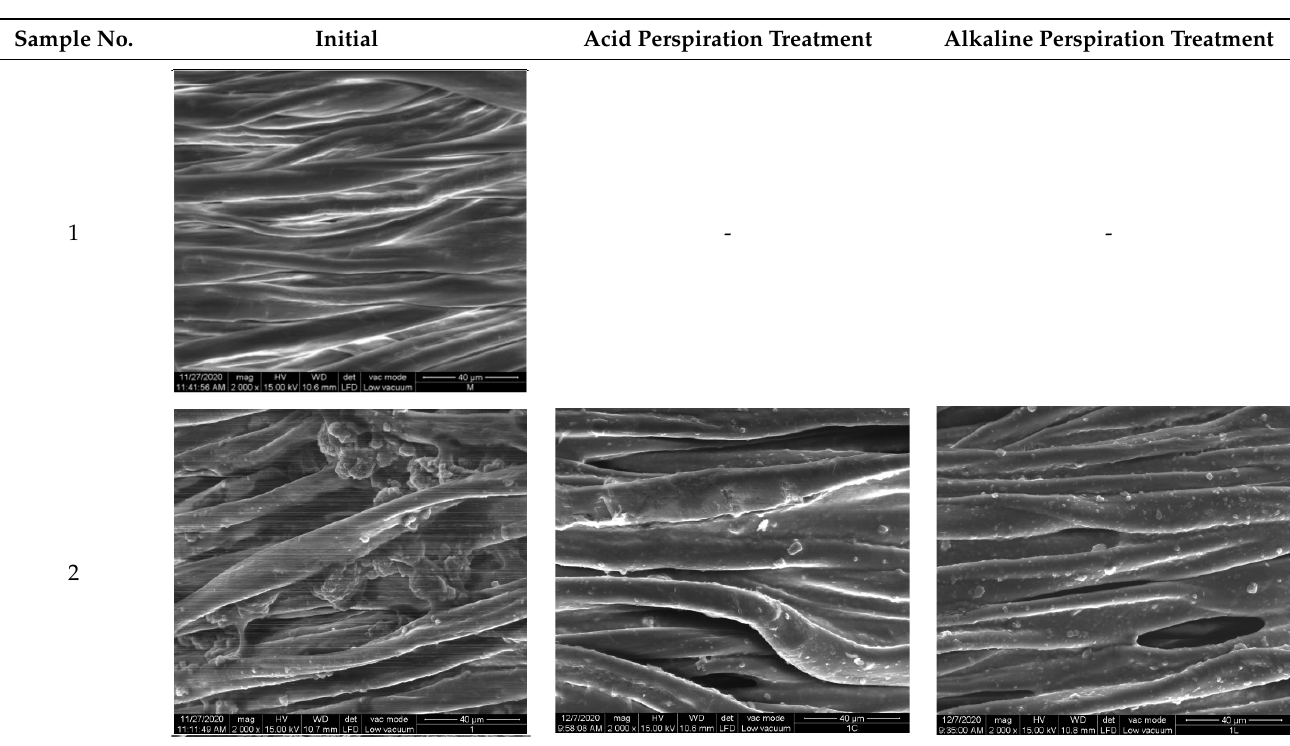
Table 3. Surface morphology-SEM.